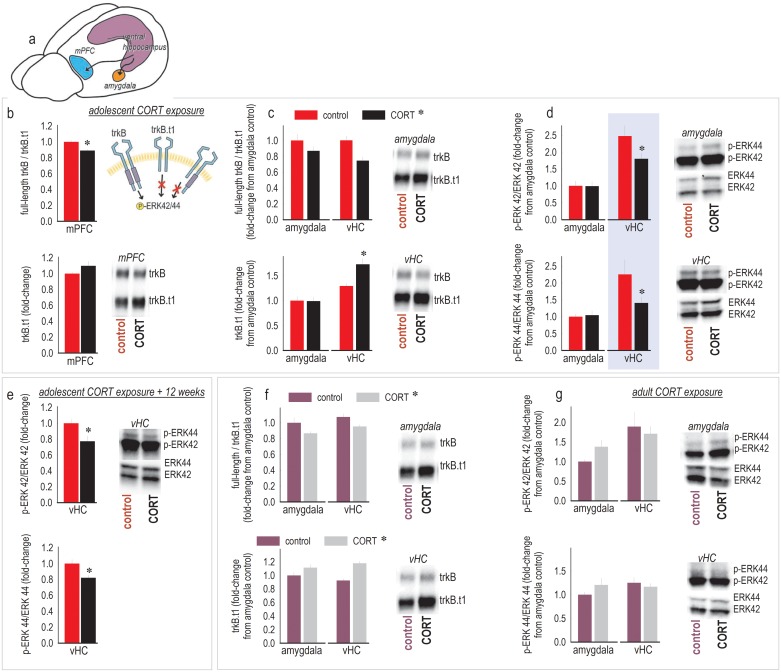
Adolescent CORT exposure regulates cortico-limbic trkB and ERK42/44 phosphorylation.(a) Based on our findings, we profiled the neurobiological effects of CORT in a mPFC–vHC–amygdala circuit. (b) Brains were first collected at the end of the CORT exposure period. Top: Adolescent CORT exposure decreased the ratio of full-length to truncated trkB in the mPFC, which would decrease the ability of full-length trkB to initiate intracellular signaling events, illustrated at right. Bottom: trkB.t1 levels alone did not significantly differ. (c) Top: Adolescent CORT exposure also decreased the ratio of full-length to truncated trkB in the vHC and amygdala. Bottom: In the vHC, this was accompanied by an increase in overall trkB.t1 levels. (d) Top: p-ERK42 levels were higher overall in the vHC than in the amygdala, and CORT reduced vHC p-ERK42 (in planned comparisons, see also Table 3). Bottom: The same pattern was detected for p-ERK44. (e) To determine whether this effect was long lasting, we assessed ERK42/44 phosphorylation 12 wk following adolescent CORT exposure. Top: p-ERK42 was reduced in the vHC. Bottom: p-ERK44 was also blunted. (f) Next, we tested the effects of subchronic CORT in adult mice. Top: CORT decreased trkB:trkB.t1 in the amygdala and vHC, as in adolescent mice. Bottom: trkB.t1 was also elevated. (g) Despite these modifications, ERK42/44 phosphorylation was not impacted. Representative blots are adjacent throughout. These and additional analyses are summarized in Table 3. n = 4–10/group throughout. Bars/symbols = means+SEMs, * p < 0.05 versus control within the same brain region. When in the legend, asterisks indicate main effects of CORT. Raw data for this figure can be found in S1 Data. CORT, corticosterone; ERK42/44, extracellular signal-regulated kinase 42/44; mPFC, medial prefrontal cortex; p-ERK, phosphorylated ERK; trkB, tyrosine kinase receptor B; trkB.t1, truncated trkB; vHC, ventral hippocampus.